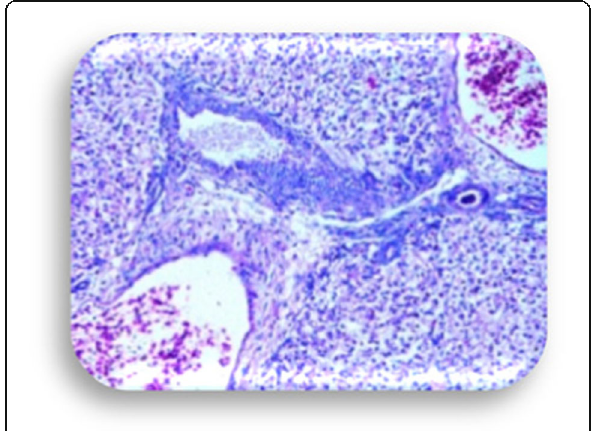
Fig. 5 Gizzard of chicken fed on 5%, 10%, and 15% cactus